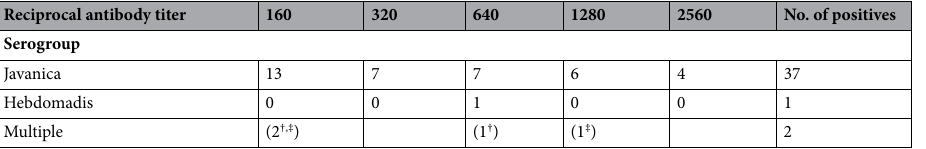
Strain Animal from which Leptospira strain was isolated Year of isolation Analytical